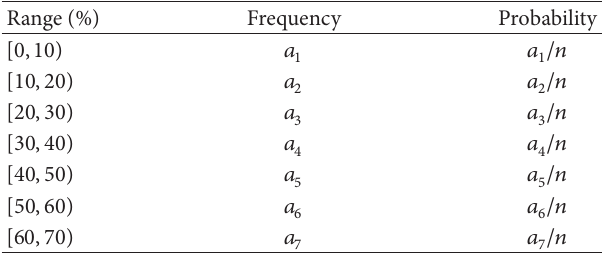
Table 1: The statistic table of the annualized volatility.